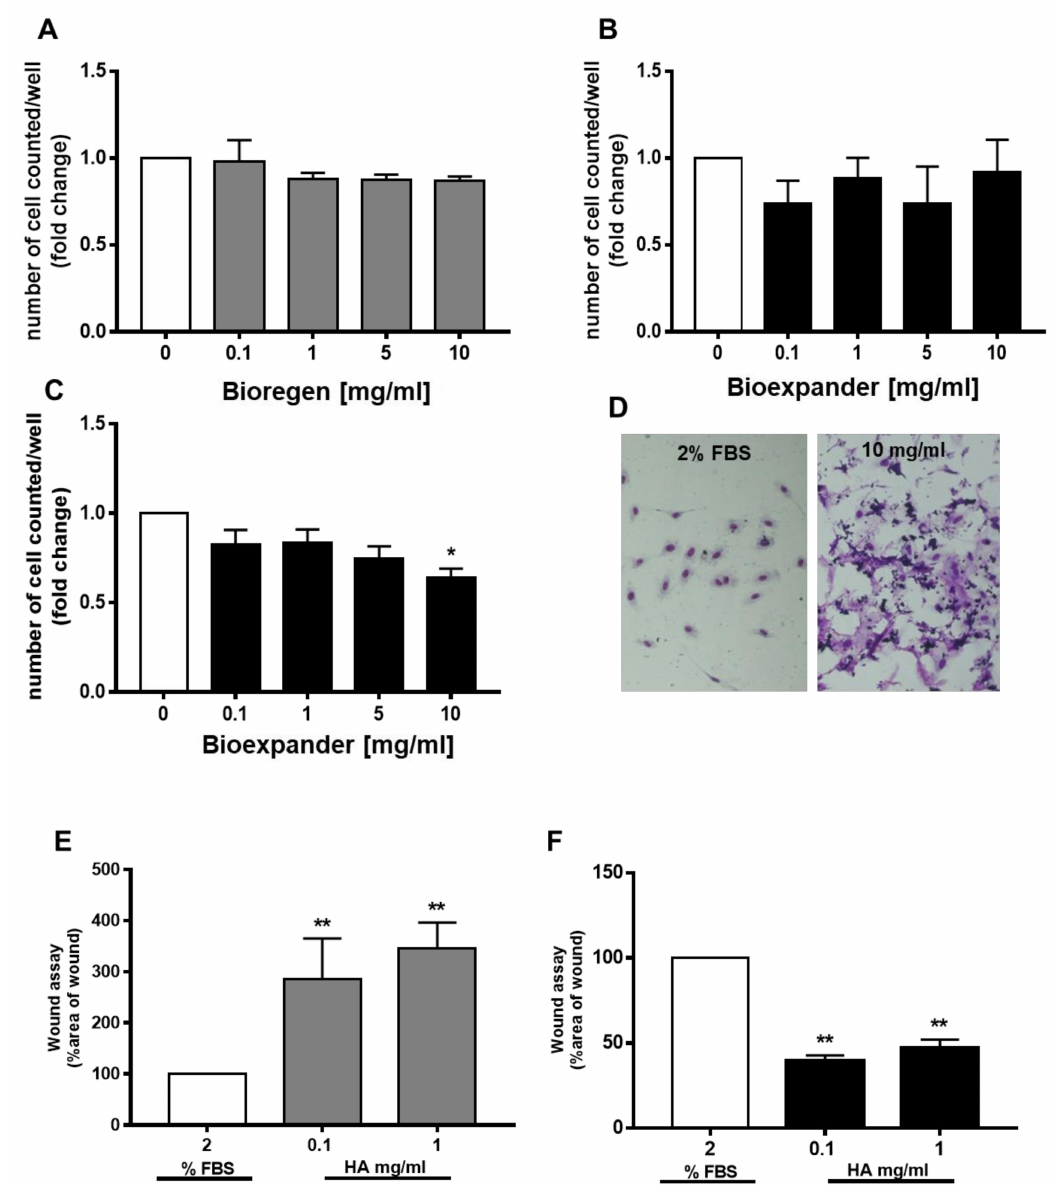
Figure 2. Endothelial cell proliferation and migration are di ff erently a ff ected by HA preparations. ( A – C ) Endothelial cells (A and B, human umbilical vein endothelial cells (HUVEC) and C, HDBEC) were exposed to increasing concentrations of Bioregen ® (grey columns) and Bioexpander ® (black columns) (0.1–10 mg / mL) dissolved in a medium with 2% serum. Cell number, index of survival, and proliferation were counted after 48 h. (n = 3). ( D ) Representative pictures of stained HDBEC in the control condition and following incubation with 10 mg / mL of Bioregen ® (4 × original quantification). ( E , F ) The migration of adherent HUVEC was evaluated by the scratch assay in confluent monolayers. The biomaterials Bioregen ® (grey columns) and Bioexpander ® (black columns) were tested at 0.1 and 1 mg / mL concentrations in the presence of 2% FBS. Graphs report the percentage of wound area with respect to time 0 (n = 3). * p < 0.05 and ** p < 0.01 vs. basal